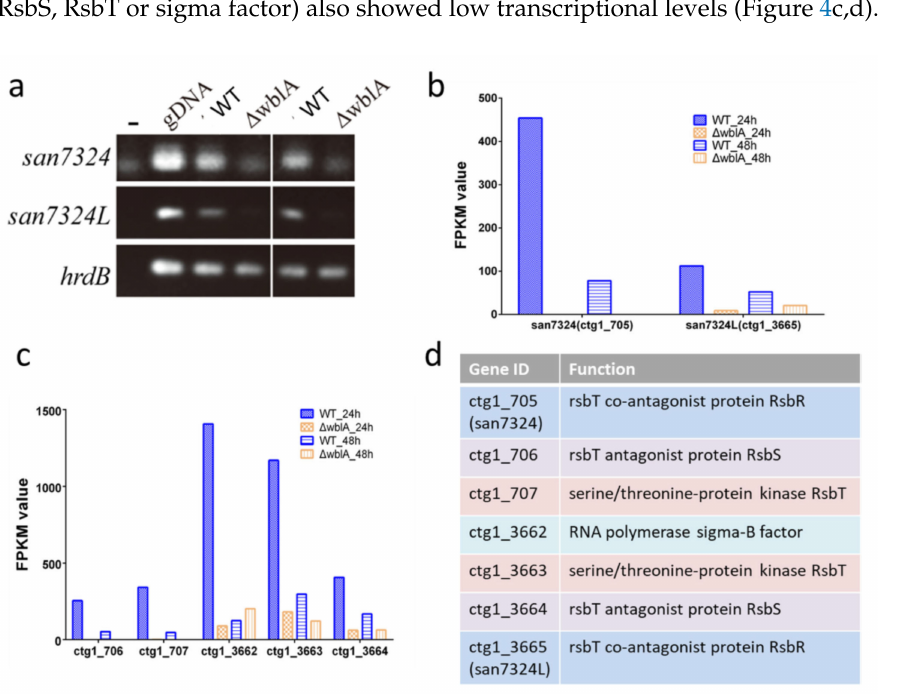
Figure 4. Transcriptional analysis of san 7324 and san 7324L in both S. ansochromogenes 7100 and ∆ wblA. ( a ) RT-PCR analysis of san7324 and san7324L , -: no DNA template was added. PCR ampli- fications with cDNA as template were repeated twice. ( b ) FPKM value of san 7324 and san7324L from RNAseq data. ( c ) FPKM value of flanking genes adjacent to san 7324 and san 7324L . ( d ) Gene annotation of ctg1_705–707 and